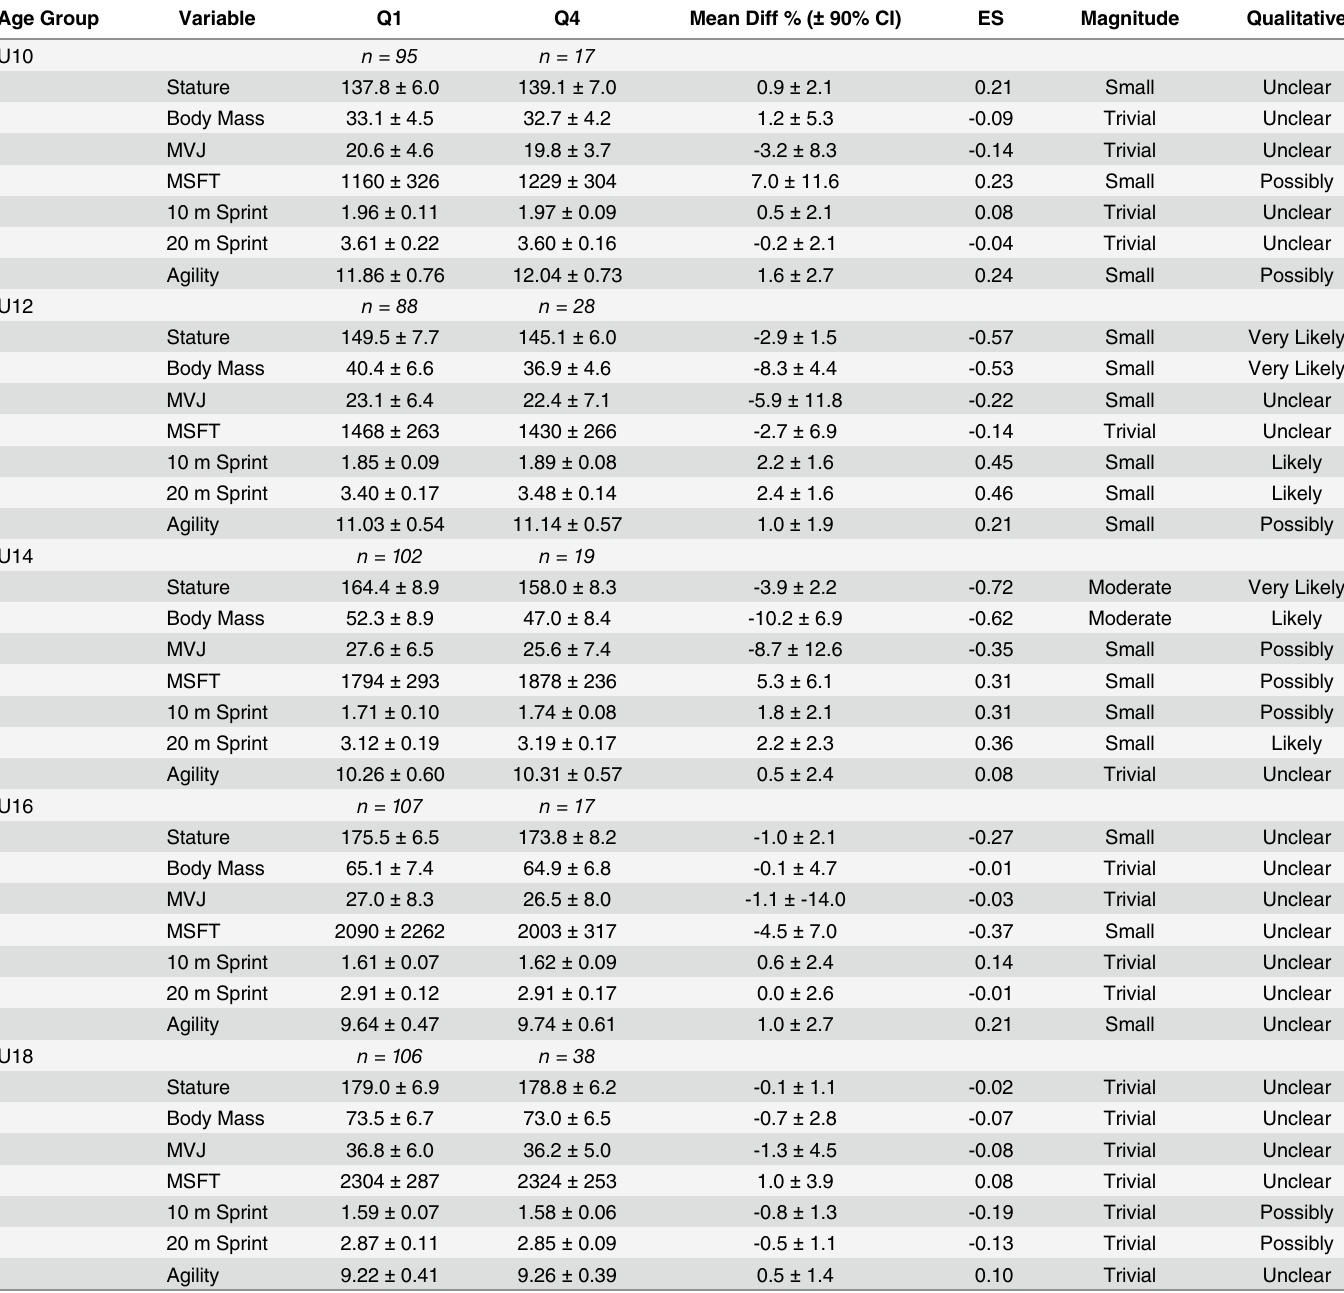
Table 4. Practical significance assessment of anthropometric & fitness capacities between relatively older and younger junior soccer players according to bi-annual age-groups.